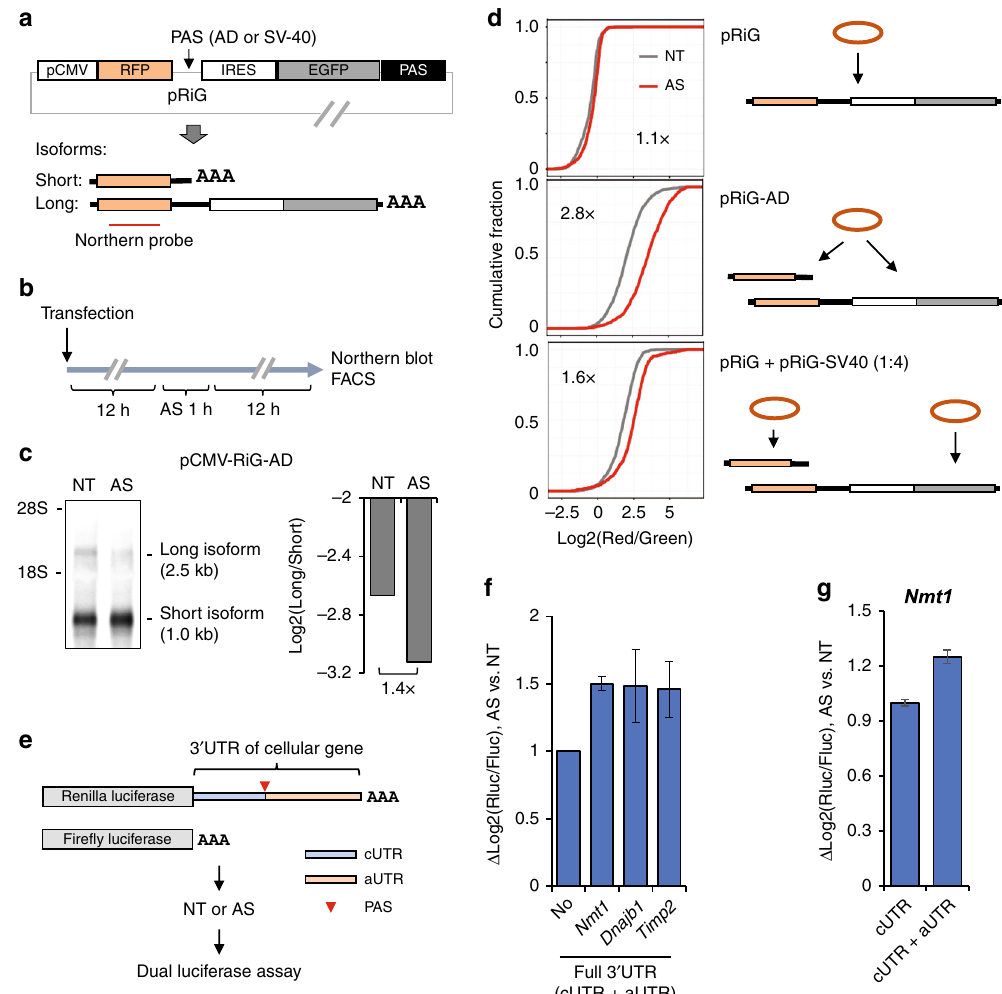
Fig. 6 Reporter assays indicate that APA confers enhanced gene expression after stress. a Schematic of pRiG-based vectors for examining of PAS usage. pRiG-AD can generate two APA isoforms because of the presence of a weak PAS between RFP and IRES-EGFP regions, as indicated. pRiG does not contain a PAS and thus expresses the long isoform only. pRiG-SV-40 has a strong PAS, leading to expression of the short APA isoform only. RFP, red fl uorescent protein; IRES, internal ribosome entry site; EGFP, enhance green fl uorescent protein. Probe for Northern blot analysis is indicated. b Schematic showing experimental design. c Left, Northern blot analysis of two APA isoforms expressed from the pRiG-AD vector in NT or AS samples. Right, Log2(ratio) of expression level of long isoform to that of short isoform shown in the Northern blot. d Left, distribution of ratios of red fl uorescence to green fl uorescence in cells transfected with indicated plasmids in NT or AS cells. Higher log2(Red/Green) values indicate more expression of the short isoform encoding RFP. The difference in median log2(Red/Green) between NT and AS cells is indicated in each graph. pRiG + pRiG-SV40 is a mixture of the two plasmids with the indicated ratio in parenthesis. Right, schematic of expression of APA isoforms from indicated plasmids. e Schematic of psiCHECK2 reporters. Full 3 ′ UTR sequences of mouse Nmt1 , Dnajb1 , or Timp2 were inserted downstream of the Renilla luciferase CDS. Fire fl y luciferase activity from the same reporter was used for normalization. f Dual luciferase assay for analysis of the effects of inserted full 3 ′ UTR sequences on expression of Renilla luciferase in AS vs. NT cells. Error bars are standard deviation based on three replicates. g Dual luciferase assay for analysis of the effect of inserted cUTR or full 3 ′ UTR sequence of Nmt1 on AS-induced regulation of expression of Renilla luciferase. Error bars are standard deviation based on two